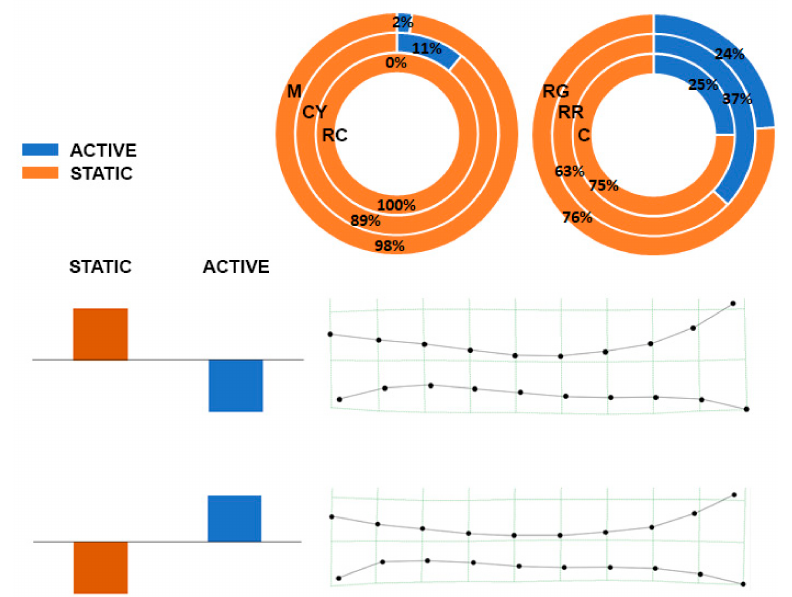
Figure 4. Partial least squares (PLS) showing the morphological relationship between the tibia and the walking/resting behavior described as percentage of time spent in two main activities (Walking W and Not Walking—NW). Percentages for each genotype are represented in pie charts. The splines depict tibia shape configuration corresponding to opposite patterns of